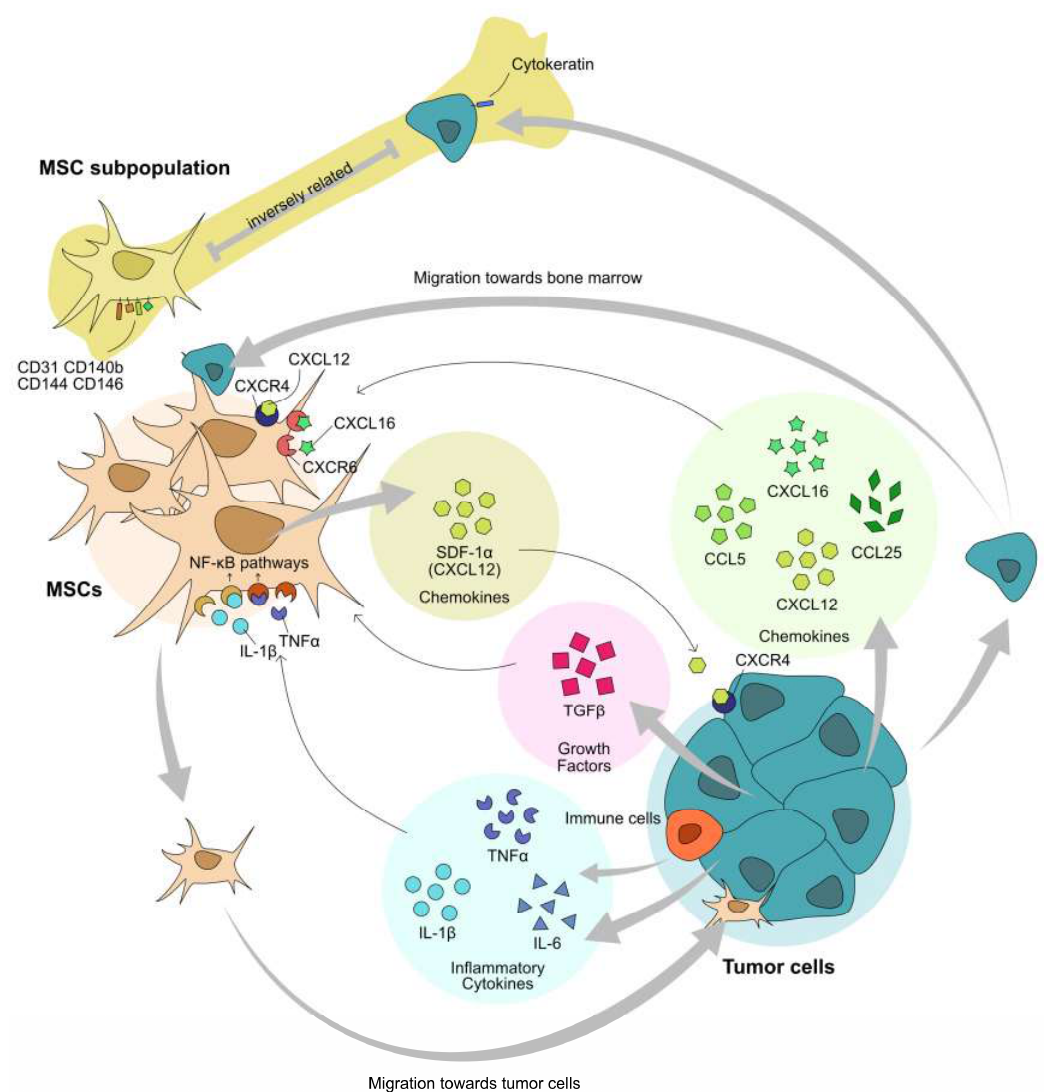
Figure 2. MSCs and tumor cells migrate towards each other. Circulating bone marrow or adipose tissue resident MSCs are recruiting to the tumor sites in the direction of multiple factors released by tumor or immune cells in the tumor microenvironment (TME). In turn, BM-MSCs could attract tumor cells into the bone morrow mediated by chemokines and their receptors. However, the subpopulation of MSCs in bone marrow inversely correlates with the cytokeratin+ cell numbers in prostate and breast cancer. Bold and thin arrows refer to cellular and molecular communications, respectively. The image was generated with Affinity Designer 1.6.1.